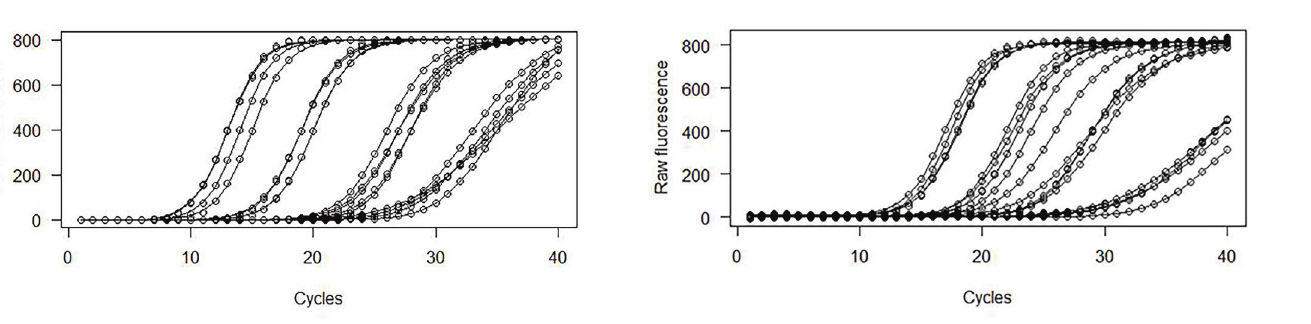
Figure 3 - Amplification of E. coli samples with 102, 104, 106,108 CFU/mL with mesenteric lymph nodes tissues